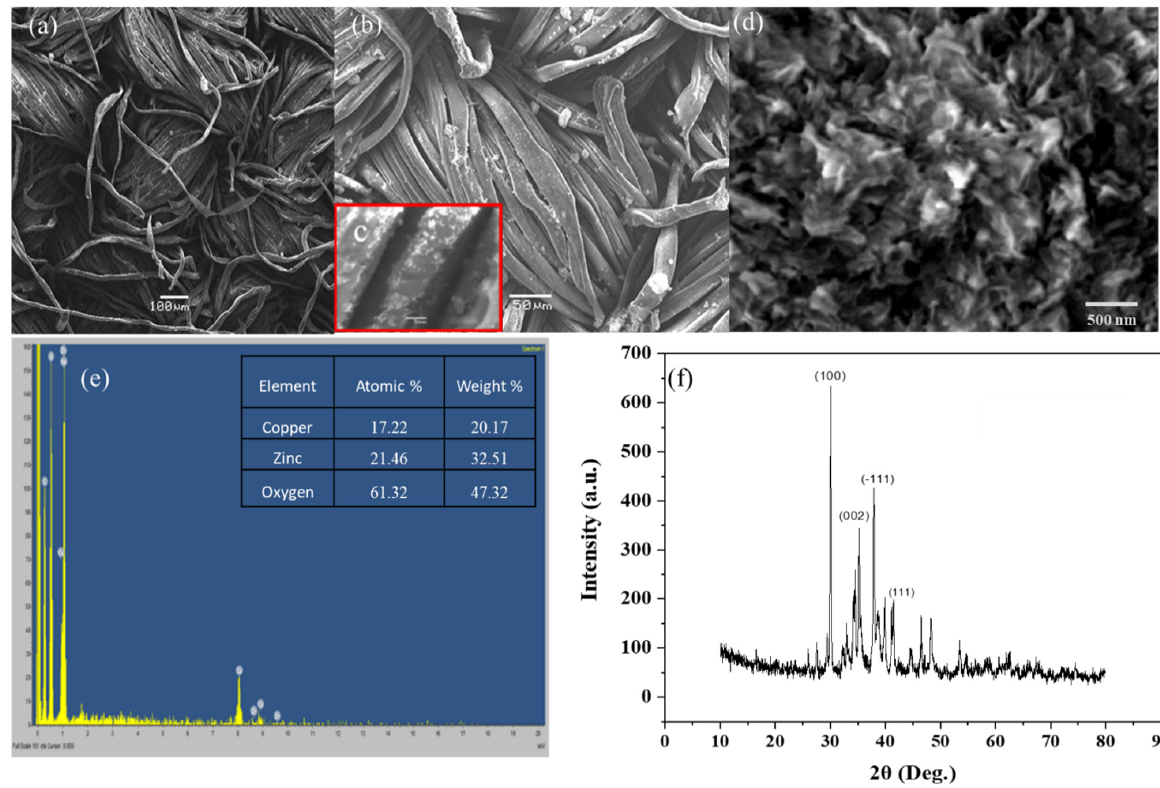
Figure 2. Structural and morphological characterization of ZnO/CuO nanoflakes grafted onto the surface of strands of PF at ( a ) 1KX, ( b ) 5 KX, and ( c ) 10 KX. ( d ) Nanoflakes of ZnO/CuO composite. ( e ) EDX spectrum and ( f ) diffractogram of ZnO/CuO composite grafted on polyester fabric.